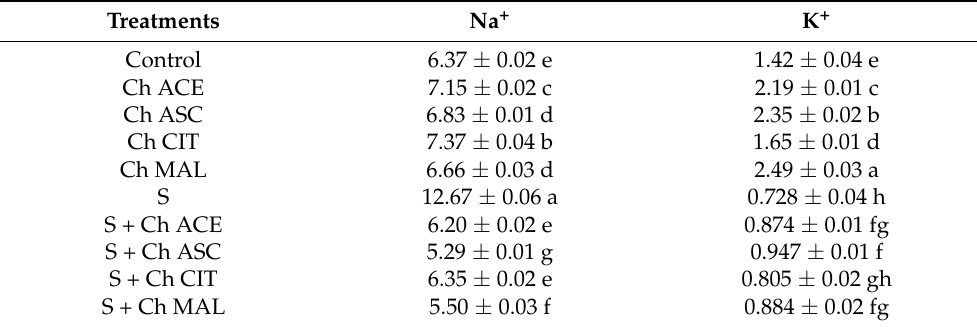
Table 2. Effect of salinity (S) and foliar application of chitosan dissolved in different organic acids (Ch ACE, Ch ASC, Ch CIT and Ch MAL) and their interactions on the Sodium (Na + ) and Potassium (K + ) contents (mg g − 1 DW) of tomato plants. Data are presented as means ± SE (n = 3). Data followed by different letters are significantly different following Tukey’s honestly significant difference (HSD) test at p ≤ 0.05. DW: dry weight.